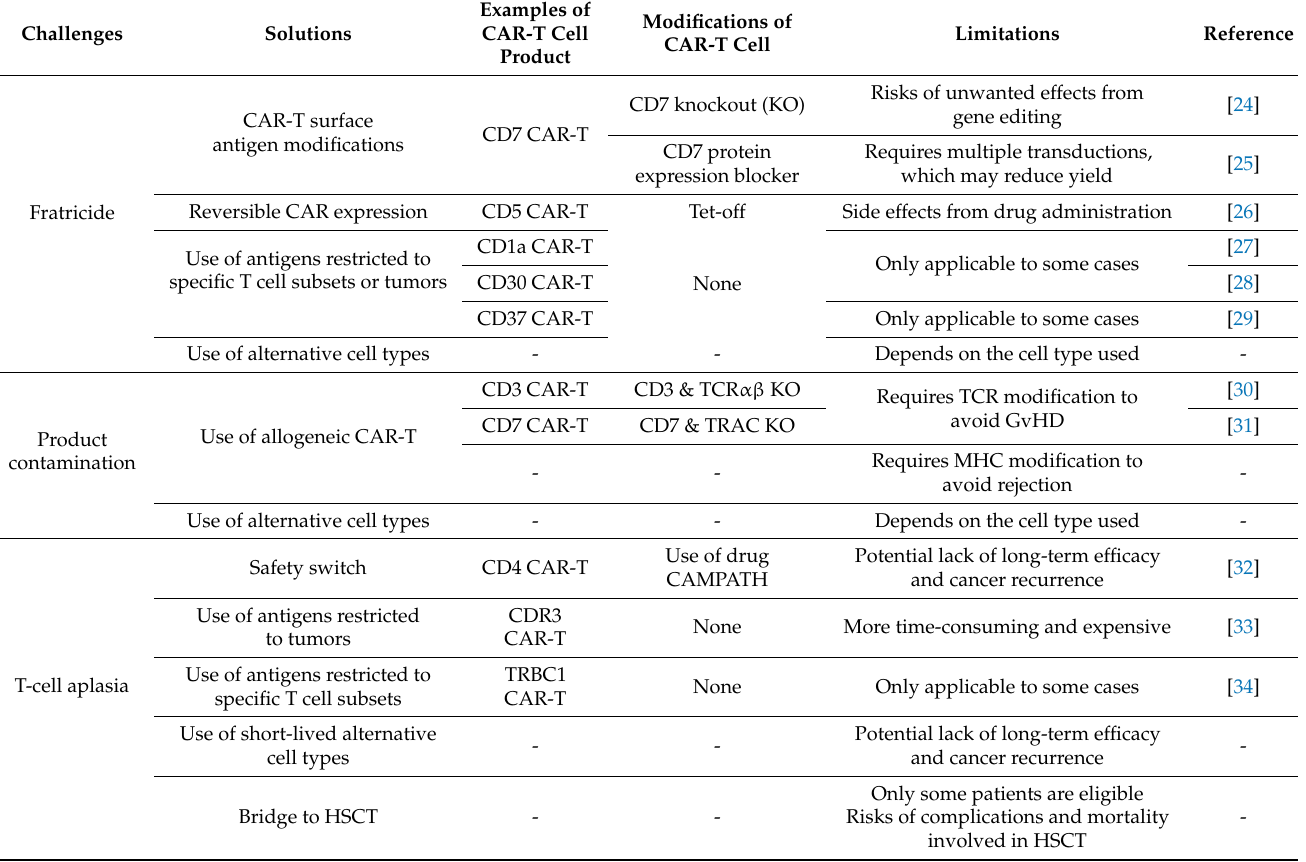
Table 1. Preclinical CAR-T cell approaches against T-cell